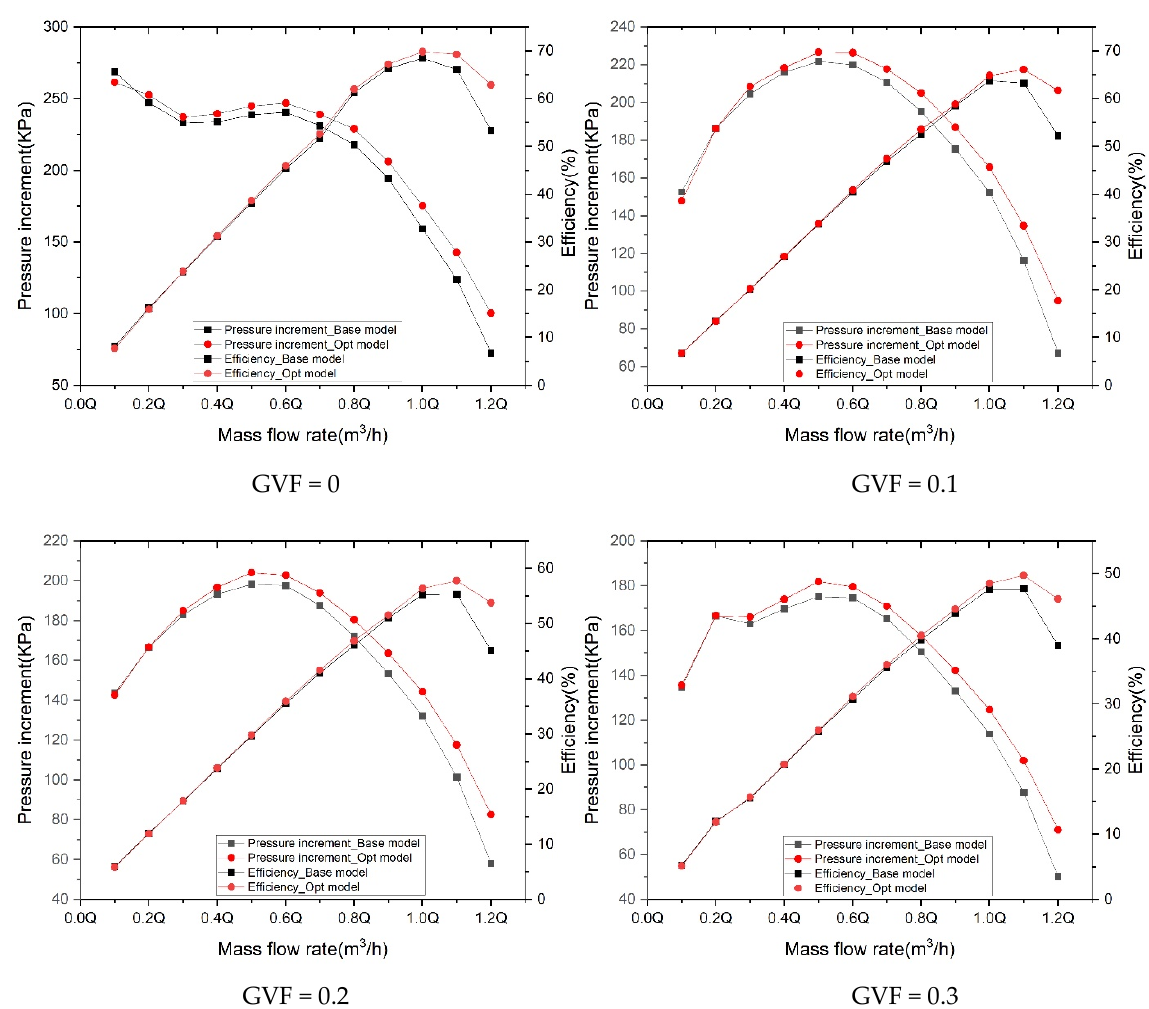
Figure 19. Characteristic curves of the multiphase pump under different working conditions.